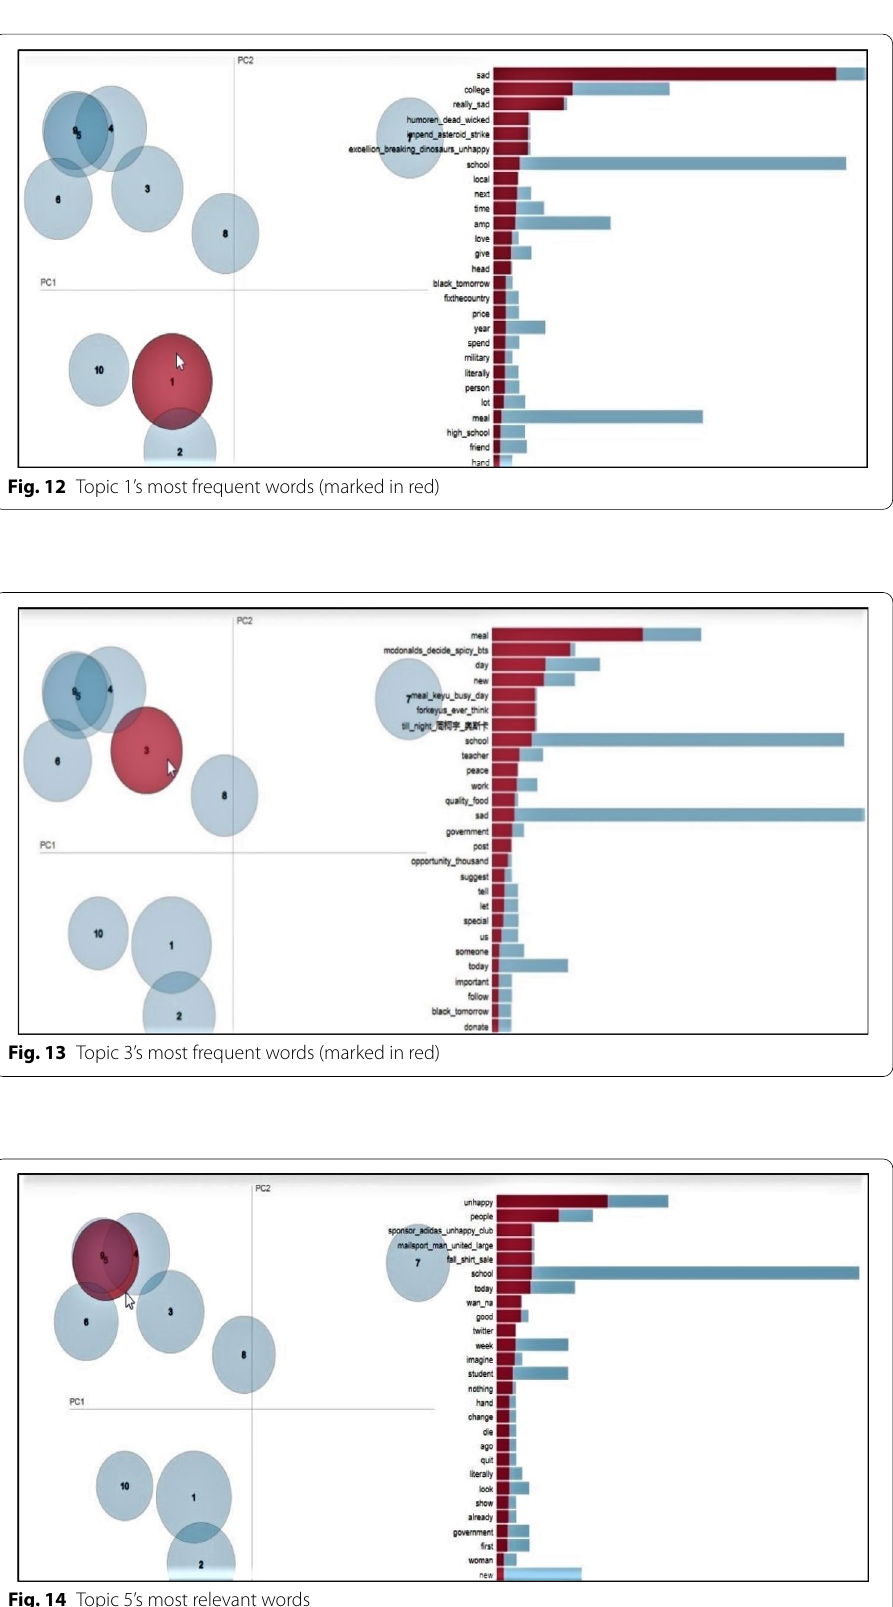
Fig. 14 Topic 5’s most relevant